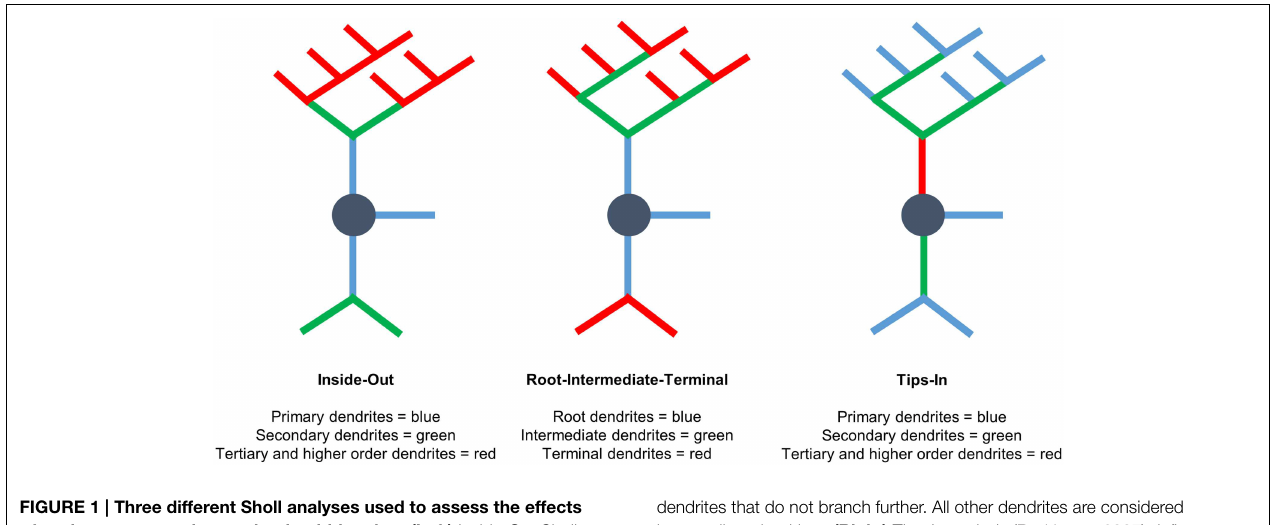
dendrites that do not branch further. All other dendrites are considered intermediate dendrites. (Right) Tips-In analysis (Rodriguez, 2007) defines terminal dendrites as primary dendrites. Secondary dendrites are dendrites that are one order in from the outermost dendrite and can be the penultimate dendrite or a root dendrite with only one branch, as shown in the figure. Tertiary and higher order dendrites are one order closer to the soma after the penultimate (secondary) dendrite. These dendrites correspond to primary dendrites in the Inside-Out labeling scheme that branch at least twice. This is a novel analysis, presented within this